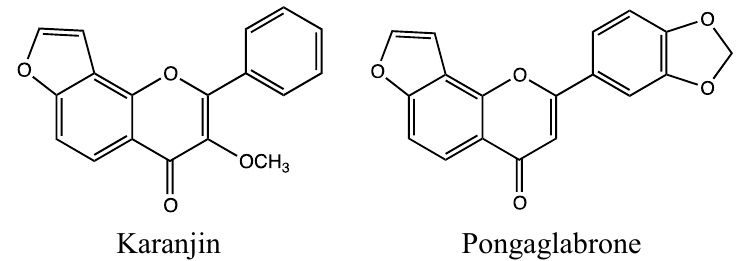
Figure 8. Flavonoids, a chromene and a triterpene from Pongamia pinnata leaves.